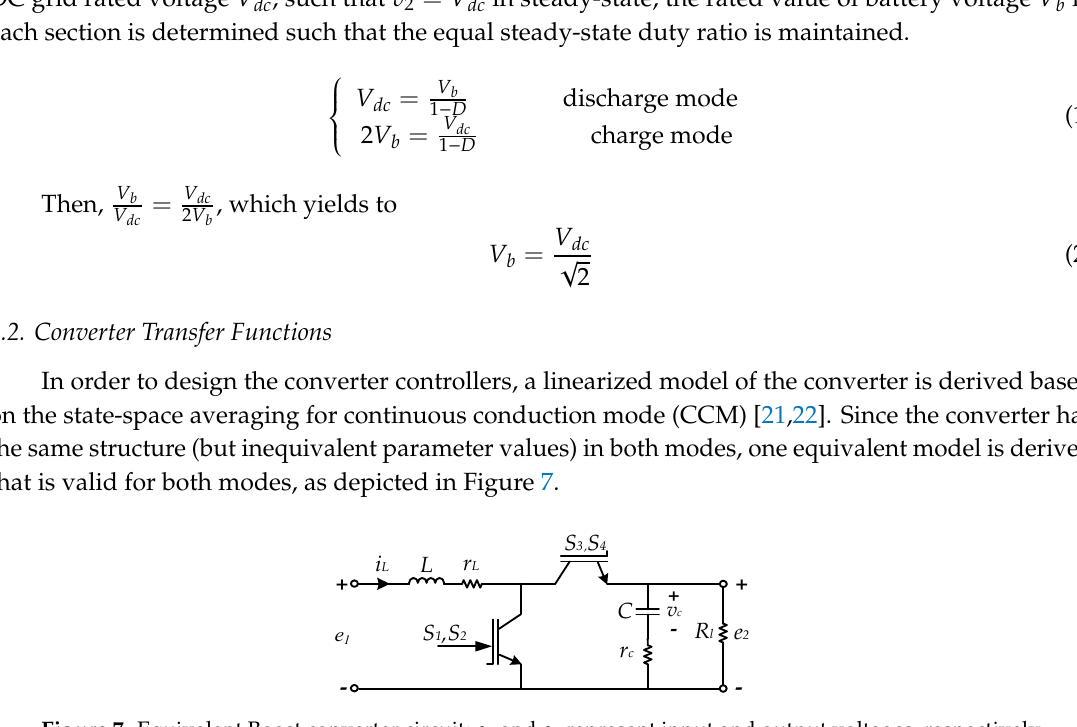
Figure 7. Equivalent Boost converter circuit; e 1 and e 2 represent input and output voltages, respectively, and R l represents the converter equivalent load in each mode.